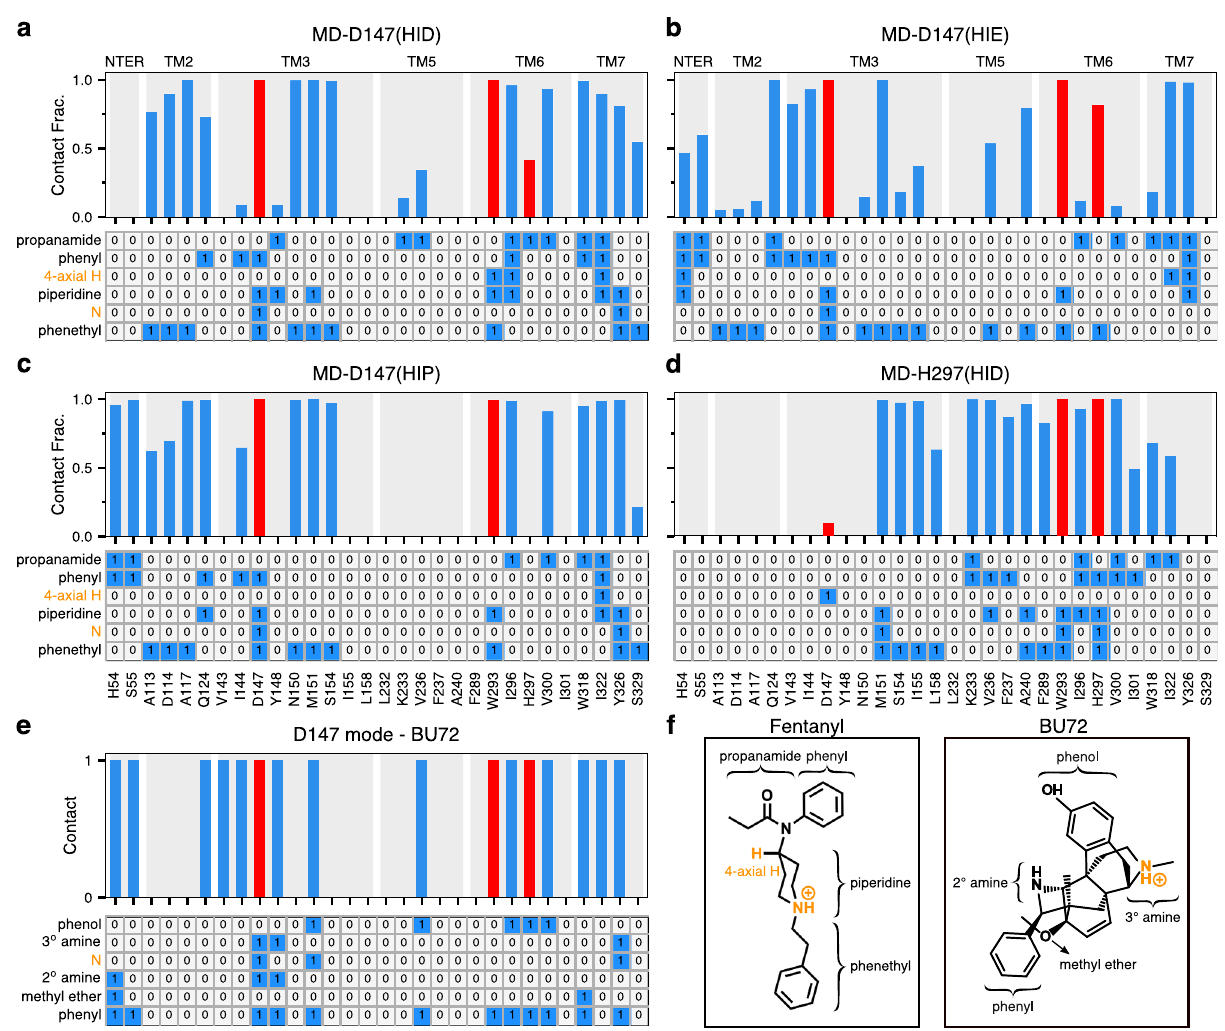
Fig. 4 Fentanyl – mOR interaction pro fi les in the presence of different protonation state of His297 and comparison to the BU72-mOR contacts in the crystal structure. a – d Top. Fraction of time that mOR residues form contacts with fentanyl in the equilibrium MD starting from the D147- ( a – c ) and H297- binding modes ( d ). A contact is considered formed if any sidechain heavy atom is within 4.5 Å of any fentanyl heavy atom. Only residues that form contacts for least 25% of the time in at least one of the six equilibrium simulations are shown. Contacts with Asp147, Trp293, and His297 are highlighted in red. a – d Bottom. Ligand-mOR fi ngerprint matrix showing the fentanyl groups as rows and mOR residue as columns. 1 represents in contact and 0 represents no contact. e mOR residues forming contacts with BU72 in the crystal structure (PDB: 5C1M 9 ). f Chemical structure of fentanyl and BU72. Different substituent groups are labeled. The 4-axial hydrogen and amine nitrogen of the piperidine group are